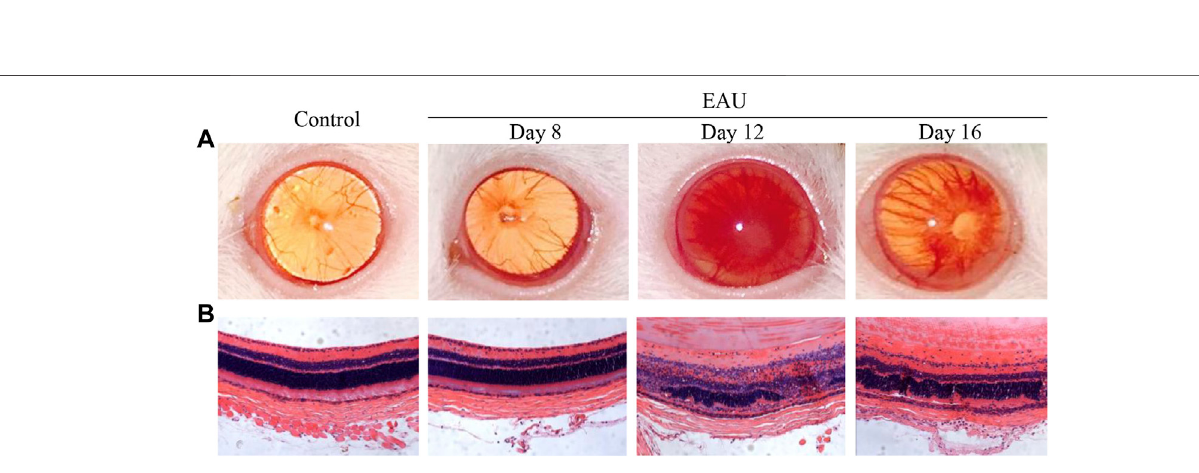
FIGURE 2 | Clinical manifestations and histopathological ocular damage in EAU eyes. (A) : Clinical appearance upon anterior chamber examination. (B) : Hematoxylin and eosin staining (H&E) of retinal tissue (×20). Control: Normal control rat eye; Day 8: 8 days after bovine IRBP immunization; Day 12: 12 days after bovine IRBP immunization; Day 16: 16 days after bovine IRBP